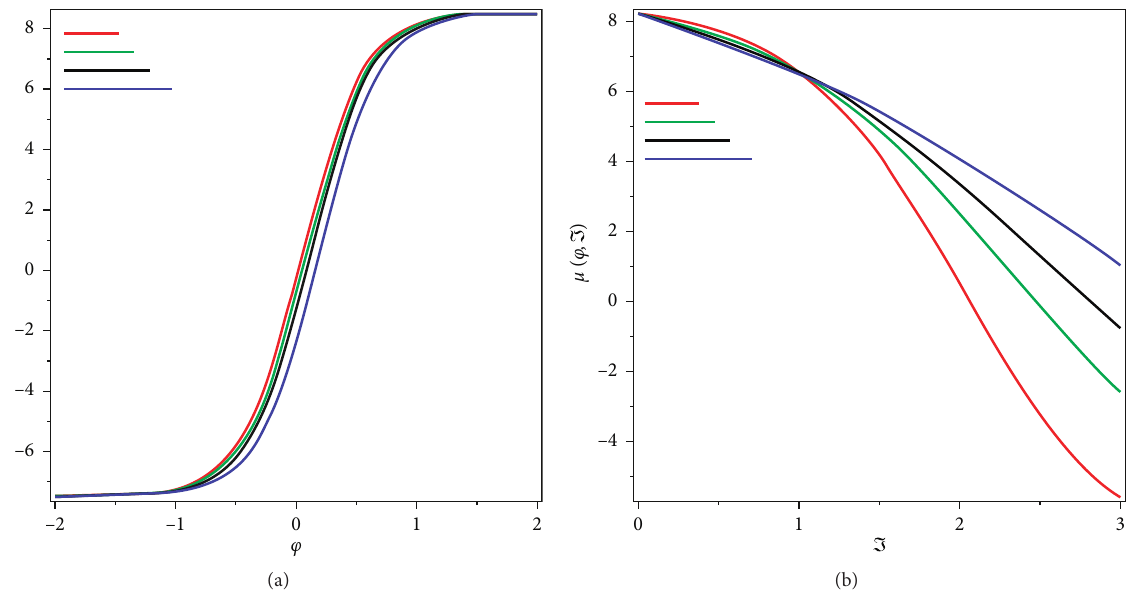
Figure 3: The different fractional-order solution with respect to the Caputo–Fabrizio operator of μ ( φ , I ) at β of Example 1.